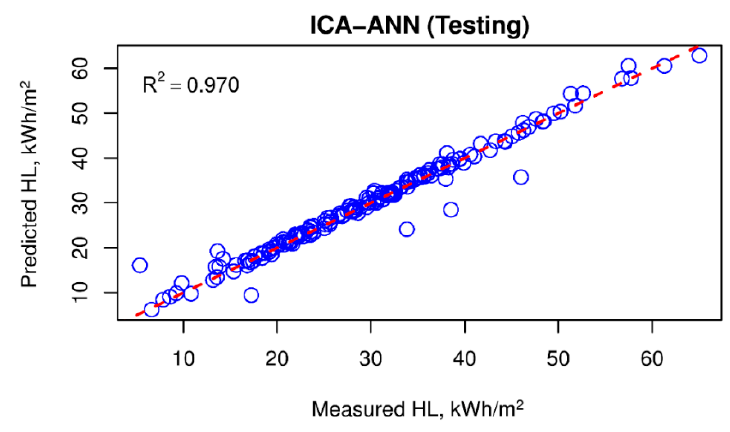
Figure 17. HL predictions on the testing dataset of the ICA-ANN model.